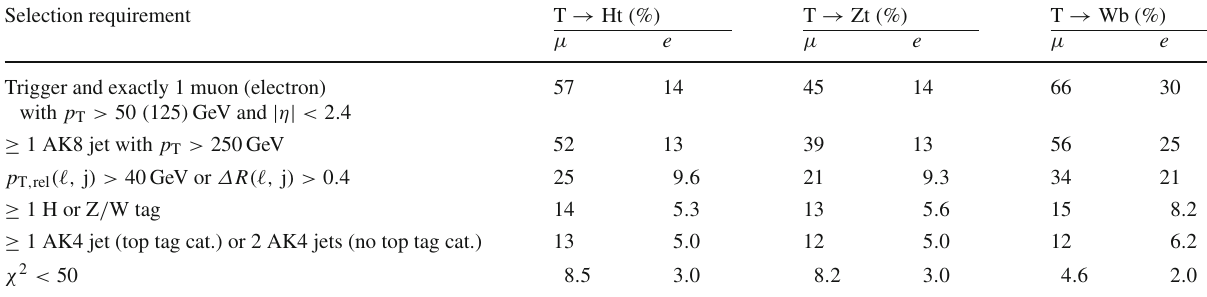
Table 2 Signal selection efficiency after each step in the selection requirements for a signal with M Z (cid:3) = 2 . 5TeV and M T = 1 . 3TeV, taking into account branching fractions B ( tHt → (cid:8) +jets ) = 0 . 294, B ( tZt → (cid:8) +jets ) = 0 . 317, and B ( tWb → (cid:8) +jets ) = 0 . 255 [64], where